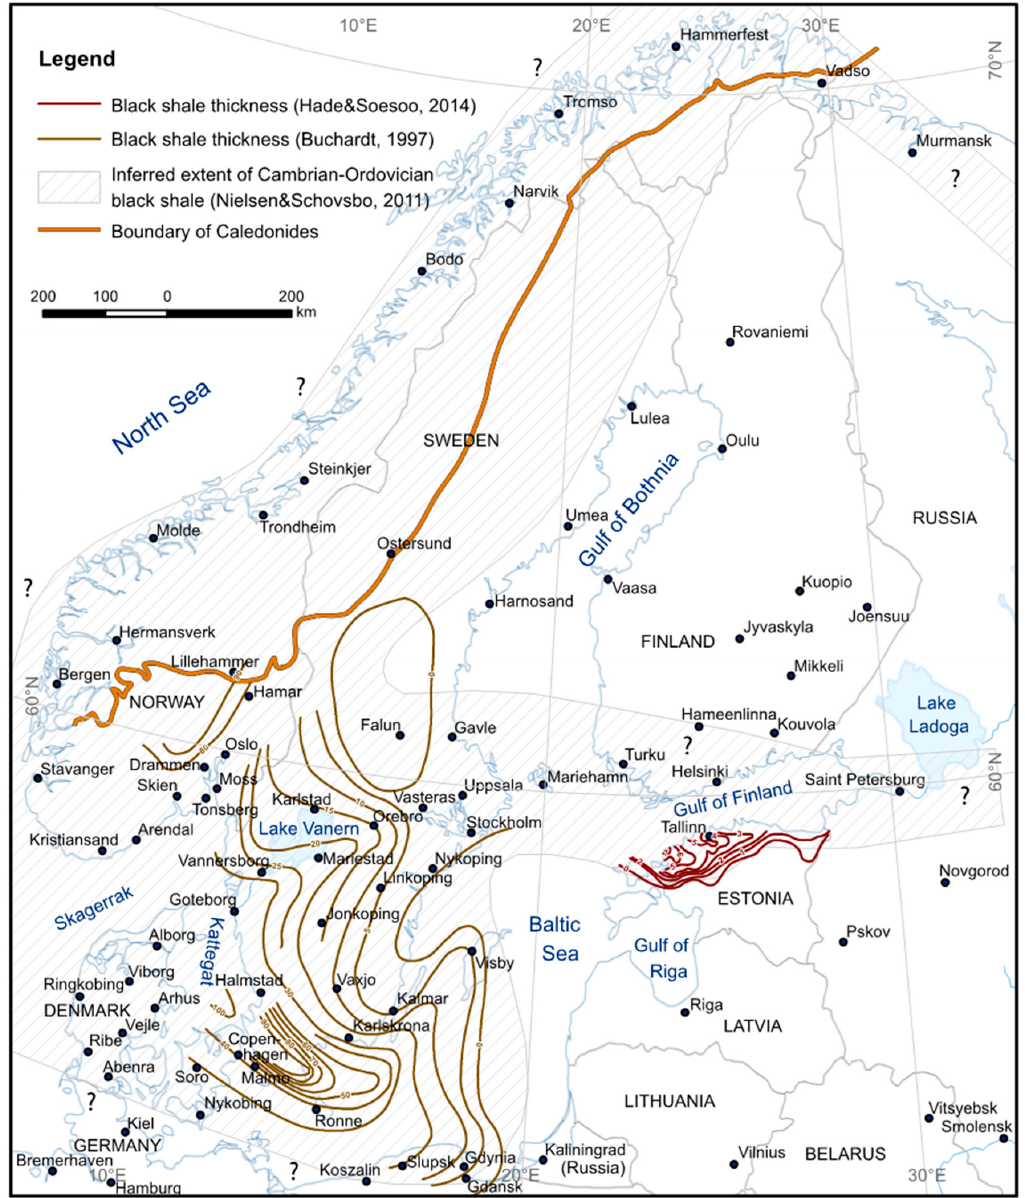
Figure 14. The extent of Cambrian–Ordovician black shale (Alum shale, graptolite argillite and Dictyonema shale) in Fennoscandia and Baltoscandia [2,65,66].